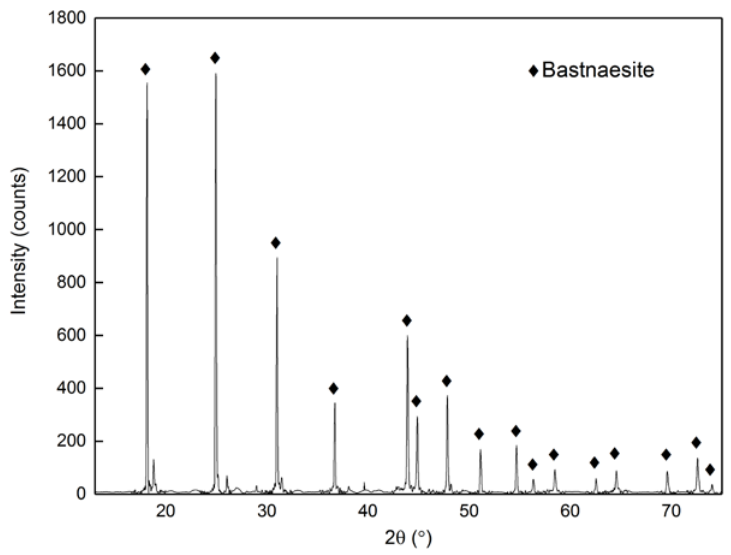
Figure 1. XRD pattern of single bastnaesite.